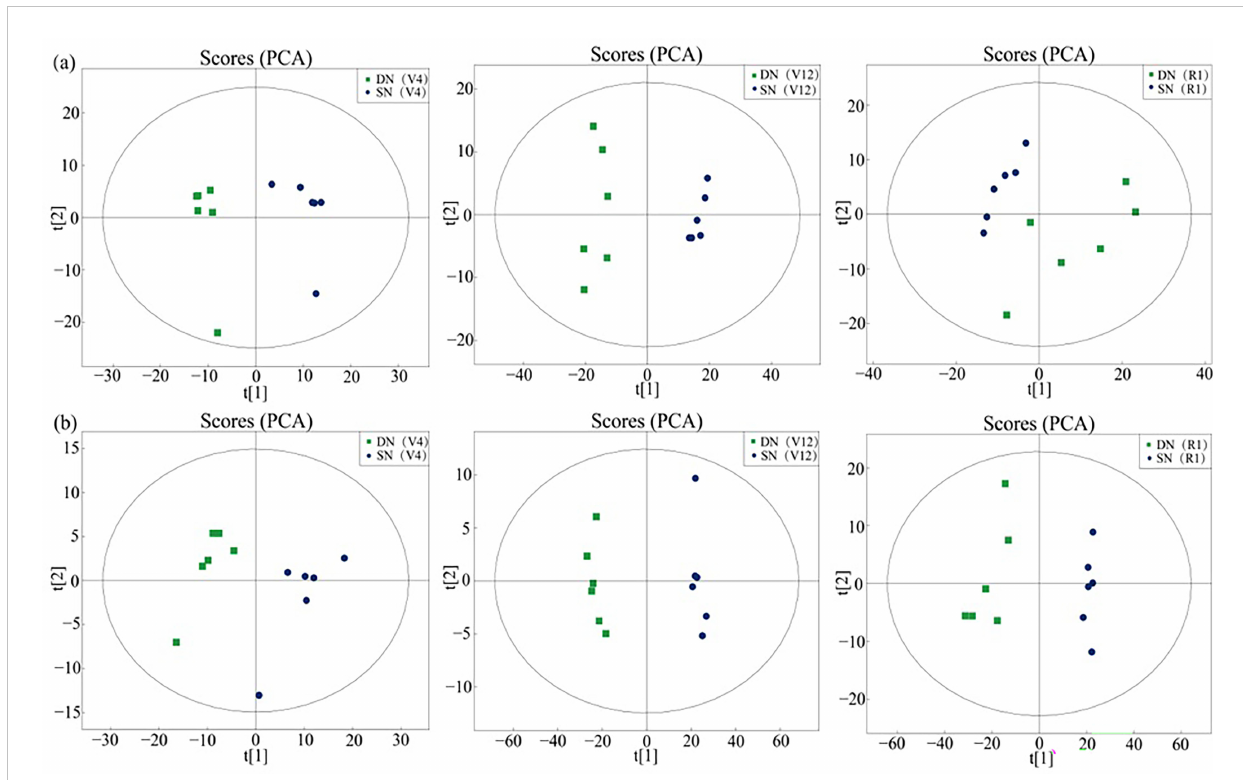
FIGURE 2 Sample score plot for the fi rst (t [1]) and second (t [2]) principal components provided by PCA for the identi fi ed metabolites in maize leaf samples (DN, SN) in ESI + mode (A) and ESI − mode (B) . Each group is represented by six